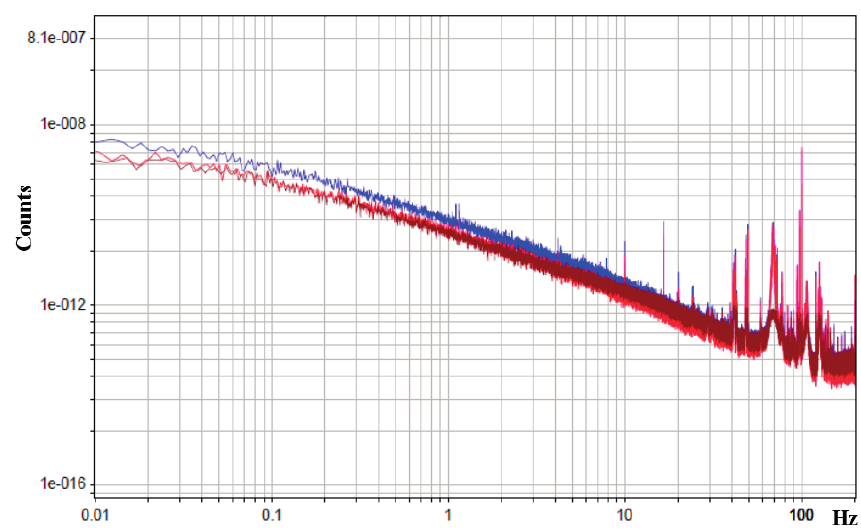
Figure 7. Power spectral density. The X-axis is the frequency in Hz, the Y-axis is the PSD counts. The blue and light red curves are the sensors PSD, the dark red curve is the PSD of uncorrelated part of the sensors